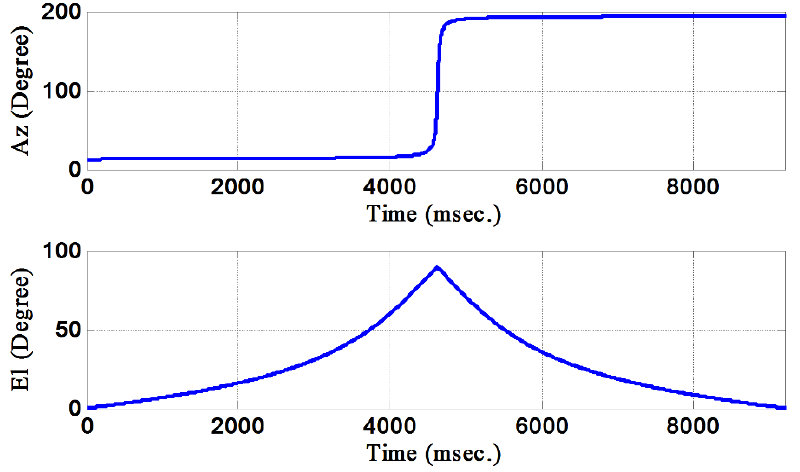
Figure 2. Satellite trajectory presented in the form of elevation ( 𝐸𝑙 ) and azimuth ( 𝐴𝑧 ) angles as the reference inputs.